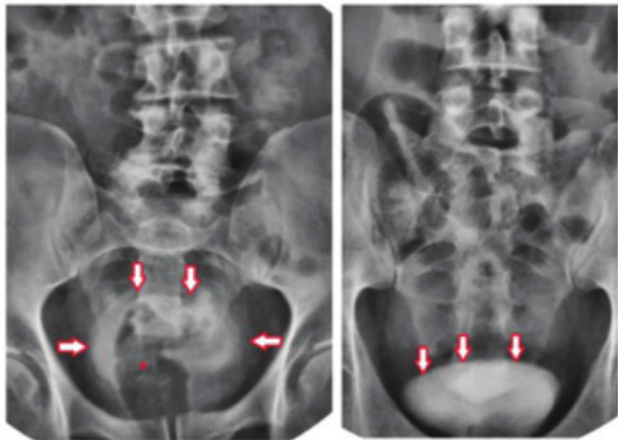
Figure 3 - CT examination of the bladder of a patient with urolithiasis. The image shows a bladder filled with contrasted urine and stones (indicated by